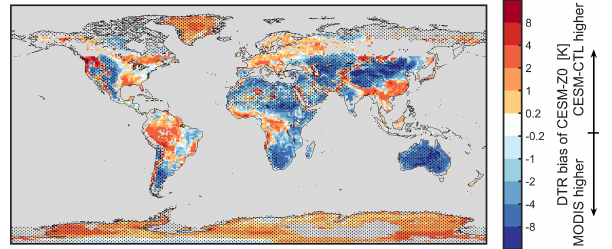
Figure A7. As Fig. 11d but for